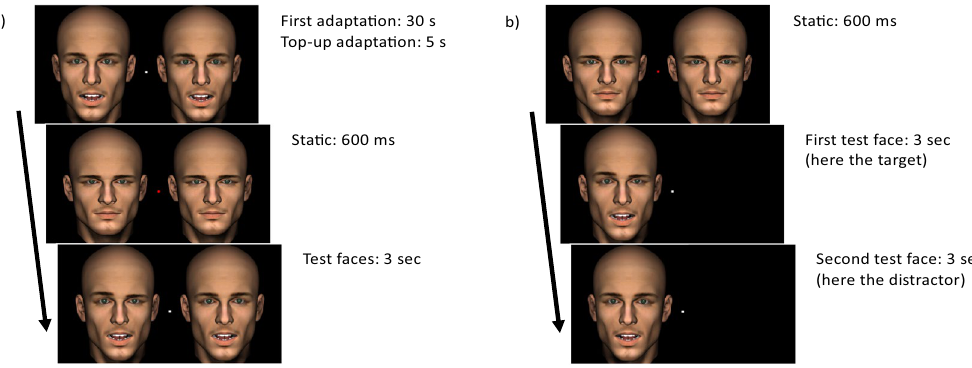
Figure 1. Stimulus and timeline. (a) Experiment 1: After adaptation to eyebrow and mouth relative movement the face was static for 600 ms followed by a 3 s period during which the dynamic test images were displayed either side of fixation. The eyebrows and jaw movements were sinusoidal (1.5 Hz) and the relative phase of mouth movements relative to eyebrow movements were either 0° (mouth opening; eyebrows dropping), 90° (mouth opening after eyebrows rising), 180° (mouth opening; eyebrows rising) and 270° (mouth opening after eyebrows dropping). All four phases were used at both adaptation and test providing 16 adaptation conditions. Four additional no-adaptation control conditions made for a total of 20 conditions. One of each pair of test faces contained misaligned eyebrow movements. The misalignment consisted of a roughly at-threshold temporal phase offset between the eyebrows of the target. The distractor face eyebrows were always aligned. Both test faces contained the same eyebrow-mouth relative timing in each trial. (b) Experiment 3: All dynamic test faces were presented to either the left or right visual fields. There was no adaptation period. Each trial was preceded by a 600 ms interval containing a static face. The two 3 s test intervals were distinguished by an abrupt change in phase. Eyebrow misalignment detection was measured at all 4 phases. Faces were also presented upright and inverted. The stimuli were generated using Poser Pro 9 (SmithMicro; https:// www. poser softw are.